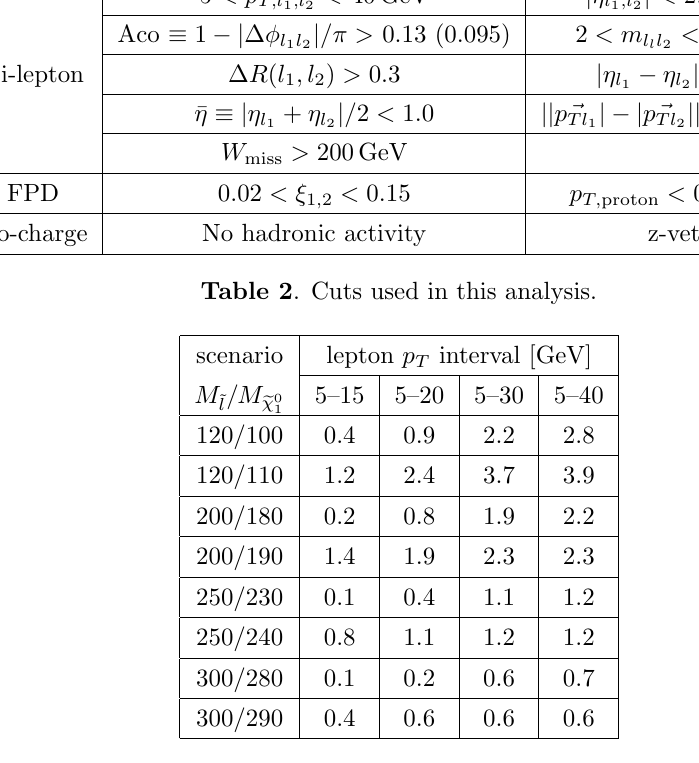
Table 3 . Signal event yields for integrated luminosity of 300 fb (cid:0) 1 for four mass assignments and four lepton p T intervals after applying all cuts speci(cid:12)ed in table 2. Yields correspond to the sum of (cid:22) + (cid:22) (cid:0) and e + e (cid:0) (cid:12)nal states observed in j (cid:17) j < 2 : 5 and to the sum of left and right-handed sleptons. Lepton reconstruction e(cid:14)ciencies taken from [15] as well as SD and DD contributions are included. production cross section via the combined e + e (cid:0) and (cid:22) + (cid:22) (cid:0) decay channels is about 1